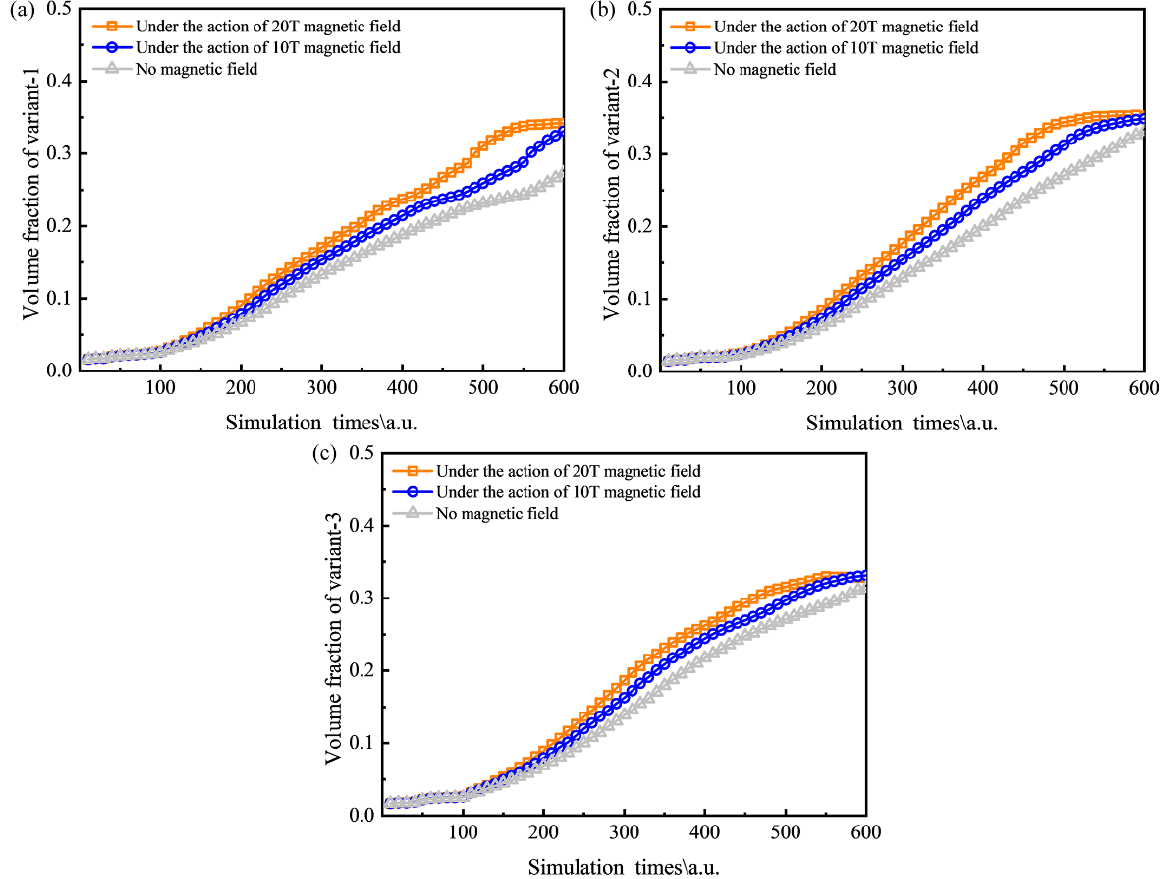
Figure 6. The kinetic curves of the three variants for different magnetic field intensities. ( a ) Variant 1, ( b ) variant 2, and ( c ) variant 3.